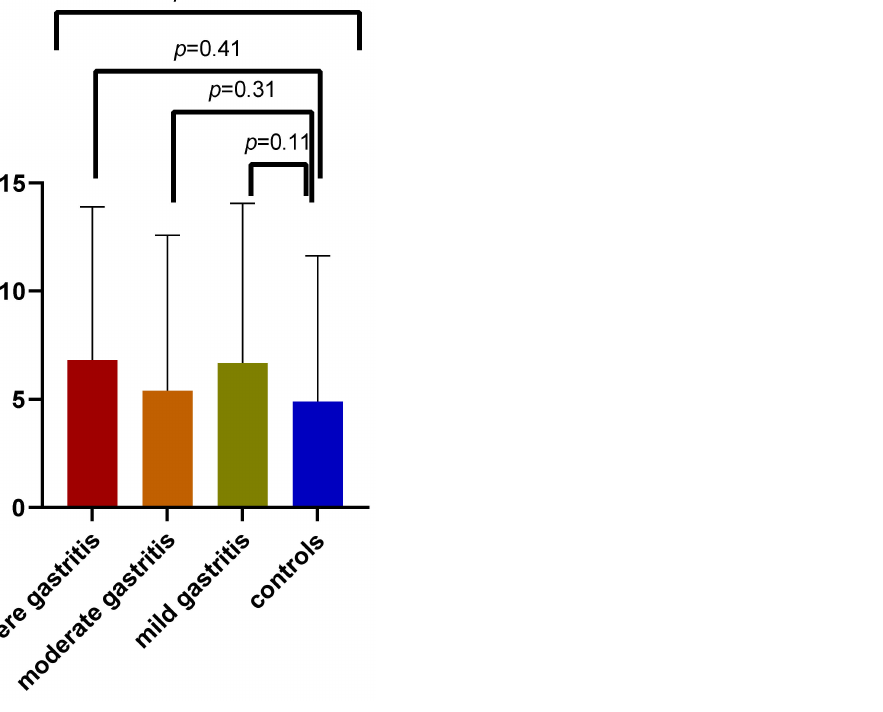
Figure 6. MiR-155 expression comparison between patients with severe gastritis, moderate gastritis, mild gastritis, and control group.